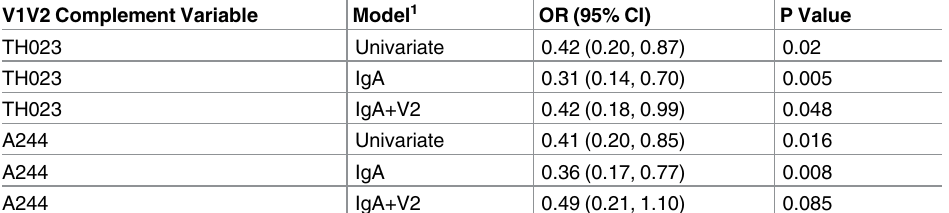
1 All models adjust for baseline behavioralrisk score and gender, and report the odds ratio (OR) of